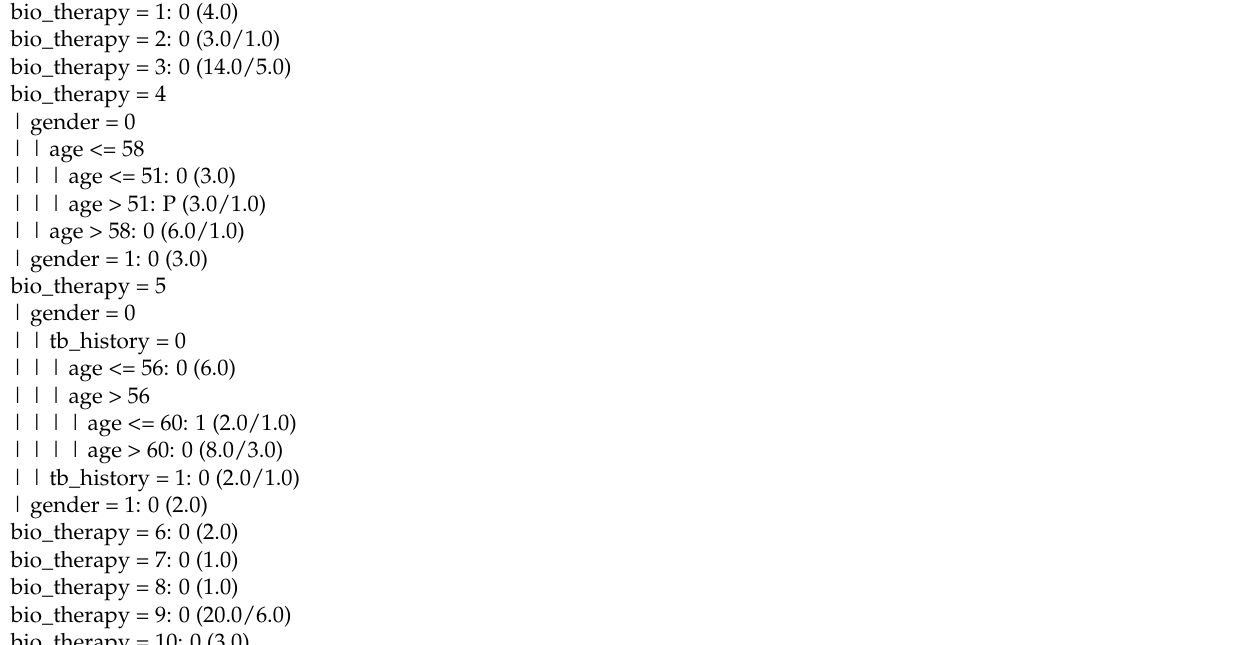
Table 14. Decision tree for the positivation of QuantiFERON-TB Gold Test with attribute selection, obtained with the C4.5 algorithm.